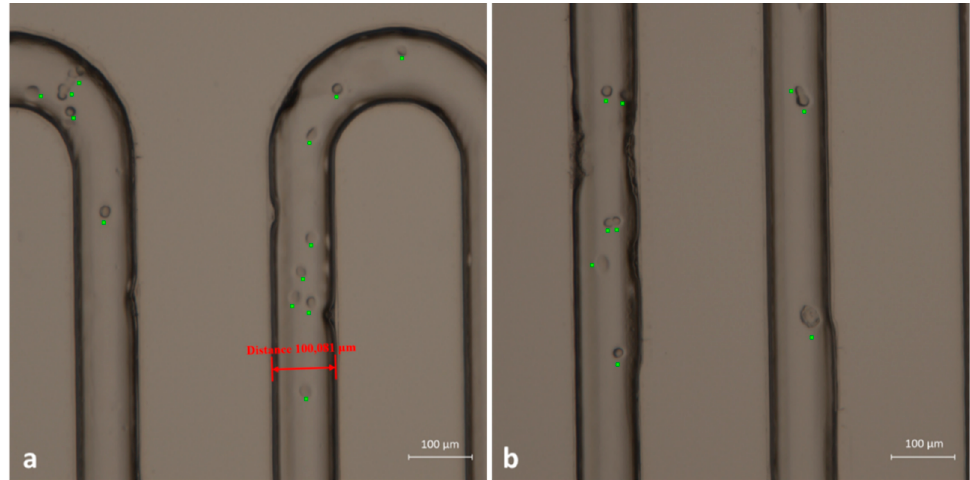
Figure 8. ( a , b ) Two frames in bright-field acquisition related to two different regions of the capture device. Attached cells are clearly recognizable and are highlighted by green crosses.